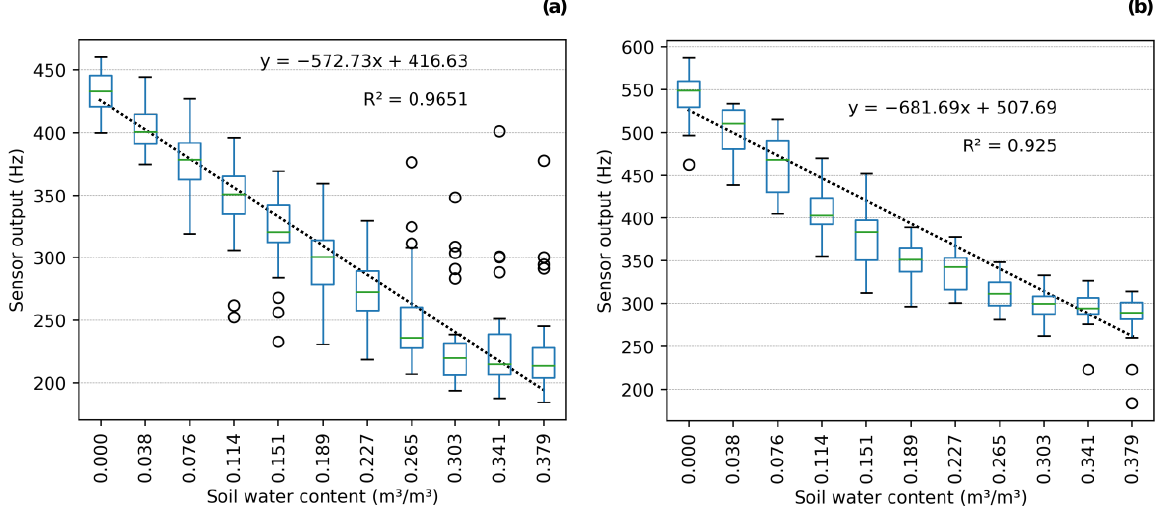
Figure 8. Single-point calibration curves for ( a ) group 1 and ( b ) group 2.